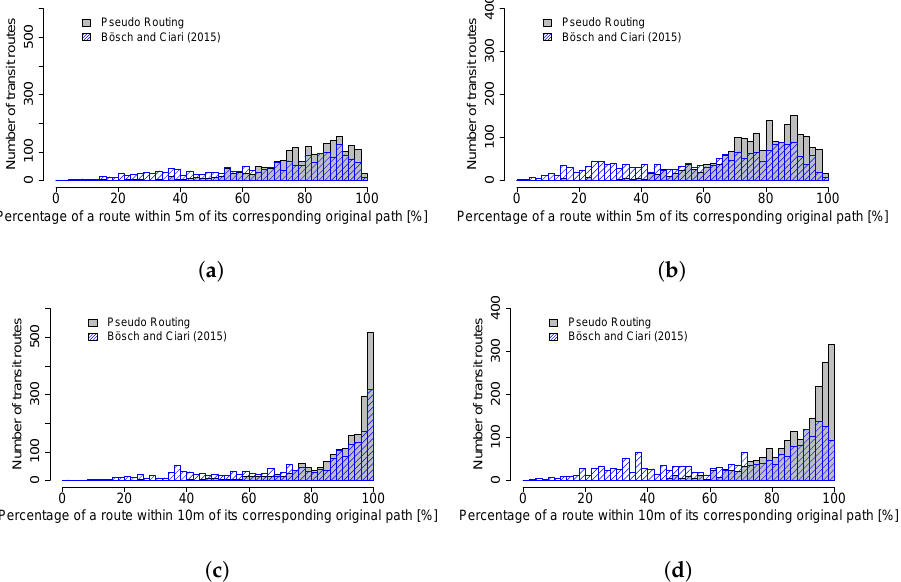
Figure 9. Histogram showing the number of transit routes for each accuracy score value. ( a ) schedule with stop locations, buffer 5 m; ( b ) schedule with parent stops, buffer 5 m; ( c ) schedule with stop locations, buffer 10 m; ( d ) schedule with parent stops, buffer 10 m.